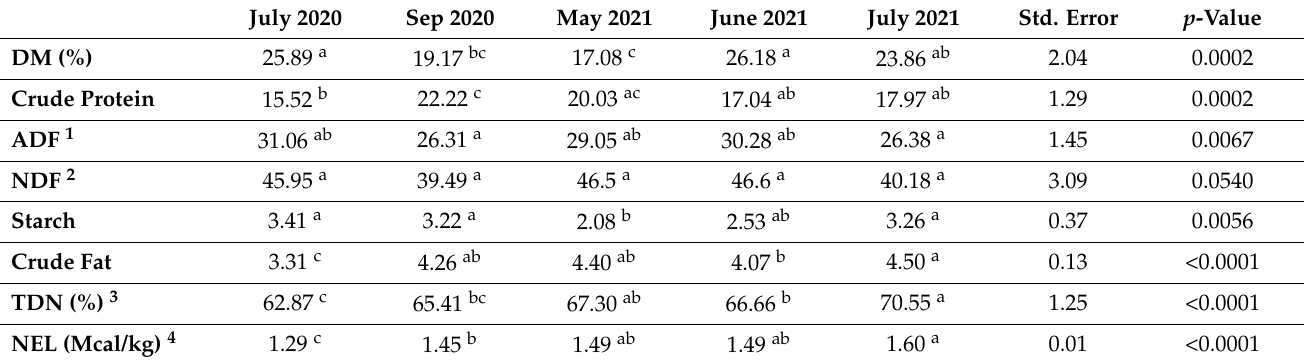
Table 2. Results of the NIRS analysis of pasture samples across different sampling times. The mean values for each pasture parameter were calculated and compared across sampling times.